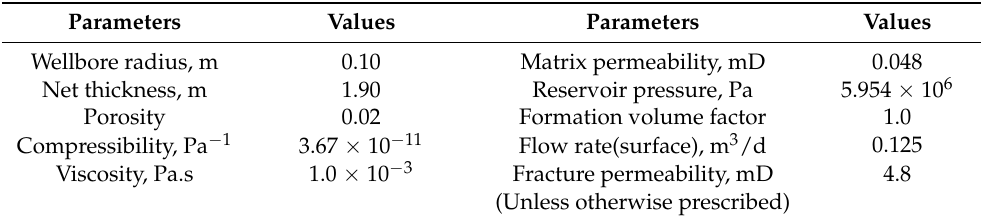
Figure 3. ( a ) The near-wellbore model scheme; ( b ) A quarter of the near-wellbore model with con- stant pressure and flow rate (top view); ( c ) Magnification of the black block in ( a ); ( d ) A heteroge- neous coal package (cross-section). Table 2. Well and reservoir parameters for all models in Section 3. Table 2. Well and reservoir parameters for all models in Section